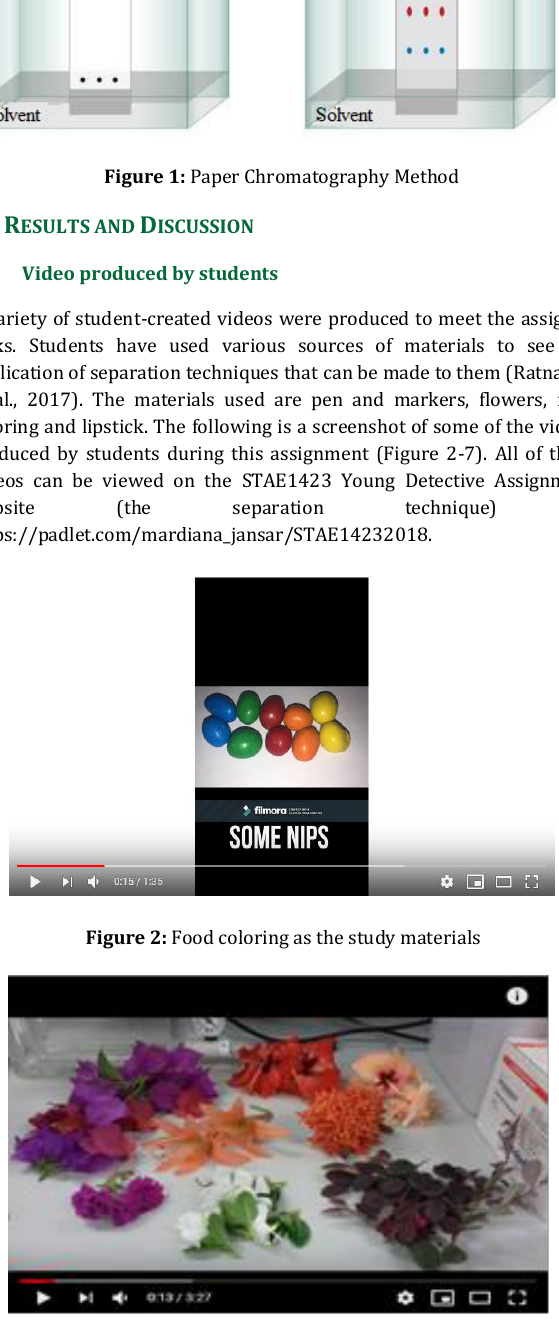
Figure 3: Flowers as study materials